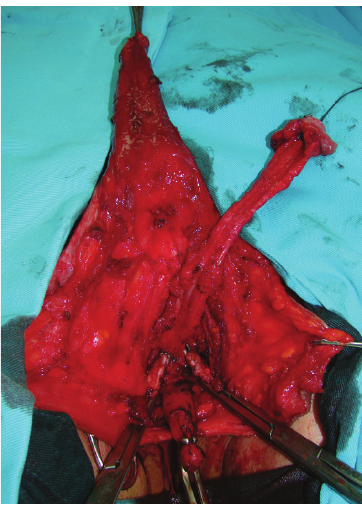
Figure 6: Neovagina is tied deeply to the sacrospinous ligament using Deschamps ligature carrier to prevent its prolapse.